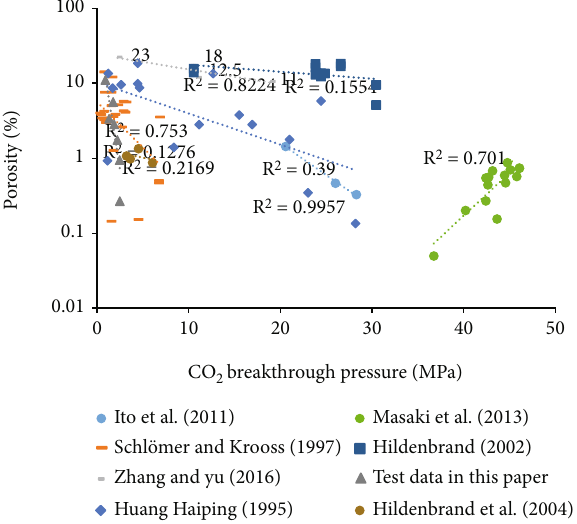
Figure 4: Relationship between porosity and CO